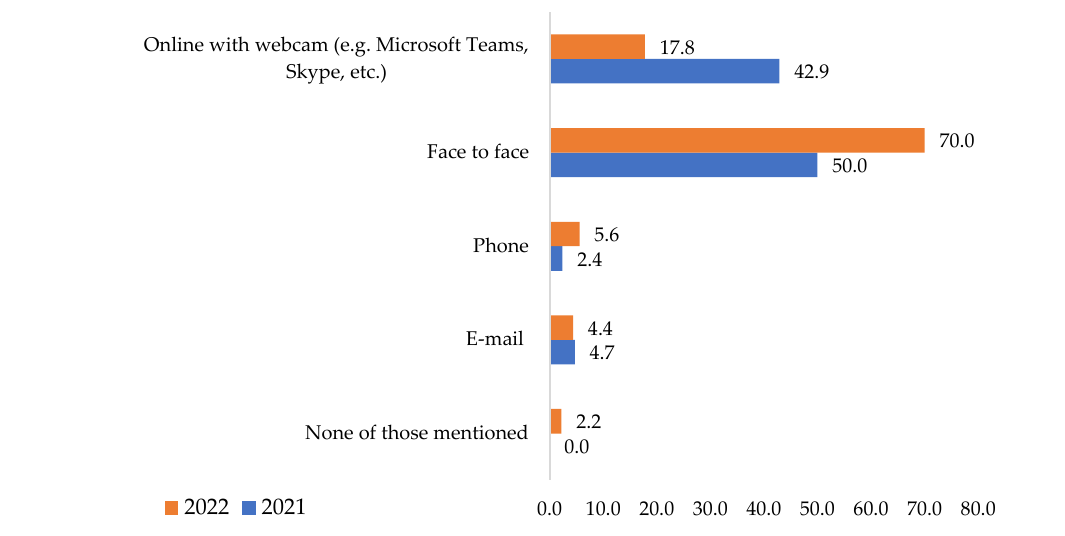
Figure 3. Communication methods preferred in working relationships. Source: Data from field quizzes, 2021, 2022.